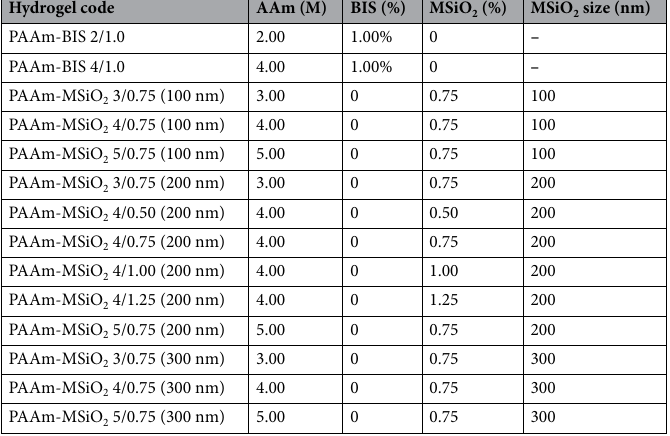
Table 1. The formulations of different types of PAAm-BIS and PAAm-MSiO 2